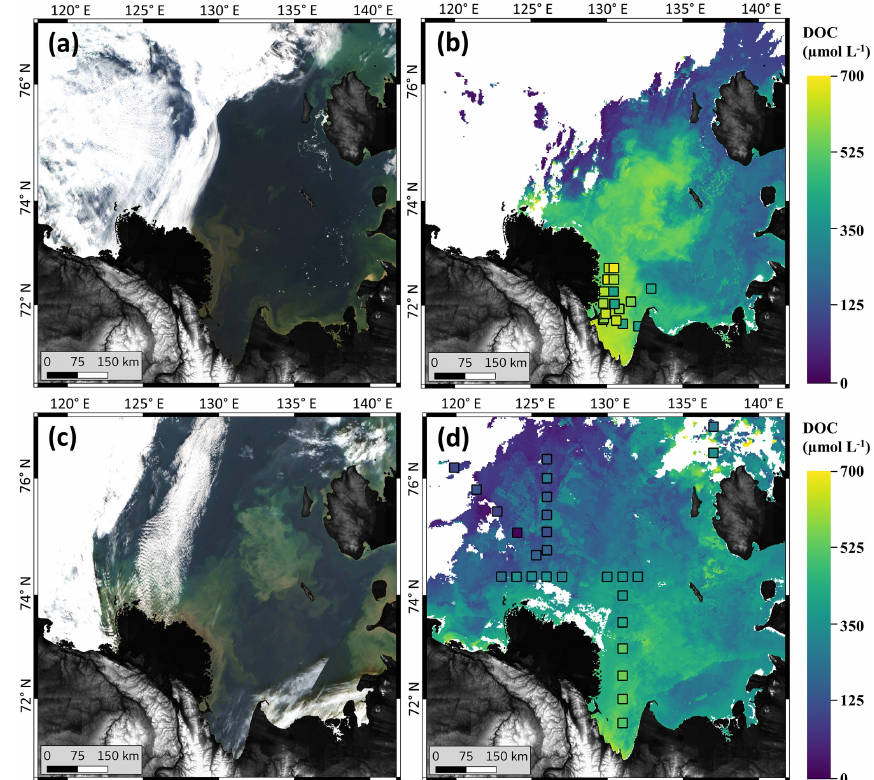
Figure 7. (a) Quasi-true colour image from 5 August 2010. (b) Surface water ONNS-DOC concentration from satellite mosaics from 3 to 5 August 2010. (c) Quasi-true colour image from 7 September 2010. (d) Surface water ONNS-DOC concentration from satellite mosaics from 7 September 2010 and 18 to 20 September 2010. Squares in panels (b) and (d) indicate in situ concentrations with the same colour scale as satellite